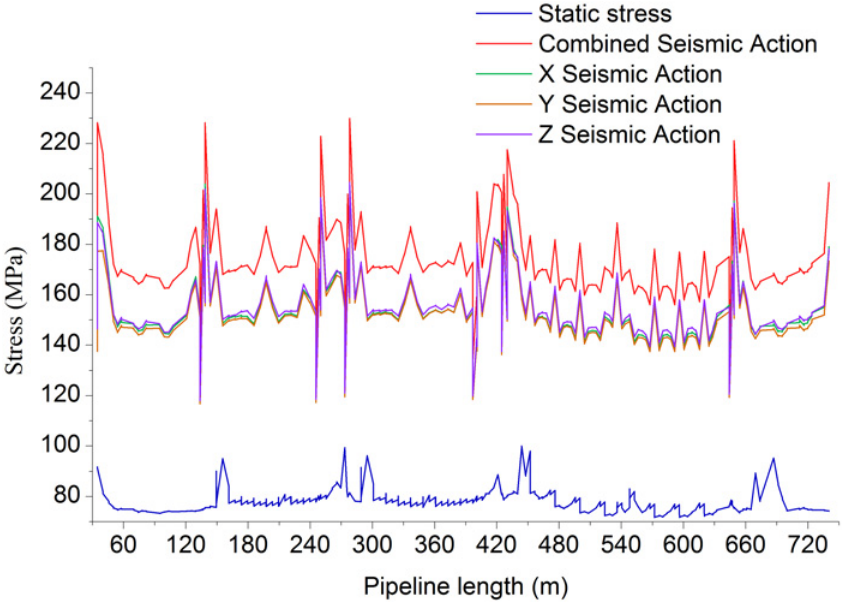
Fig 10. Pipeline stress distribution (Static and